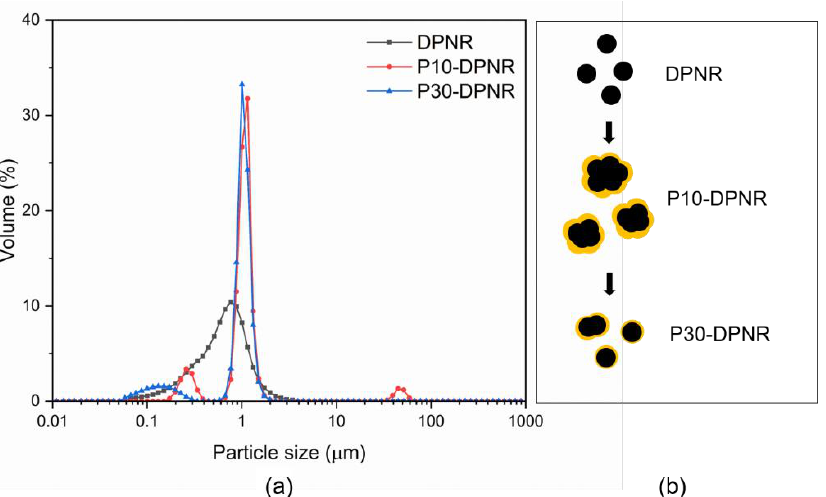
Figure 6. ( a ) Particle size distribution; ( b ) schematic representation of (PAA- co -PAM)-covered DPNR. Table 3. Particle size, zeta potential, and Tg of DPNR and (PAA- co -PAM)-DPNR with different monomer contents.